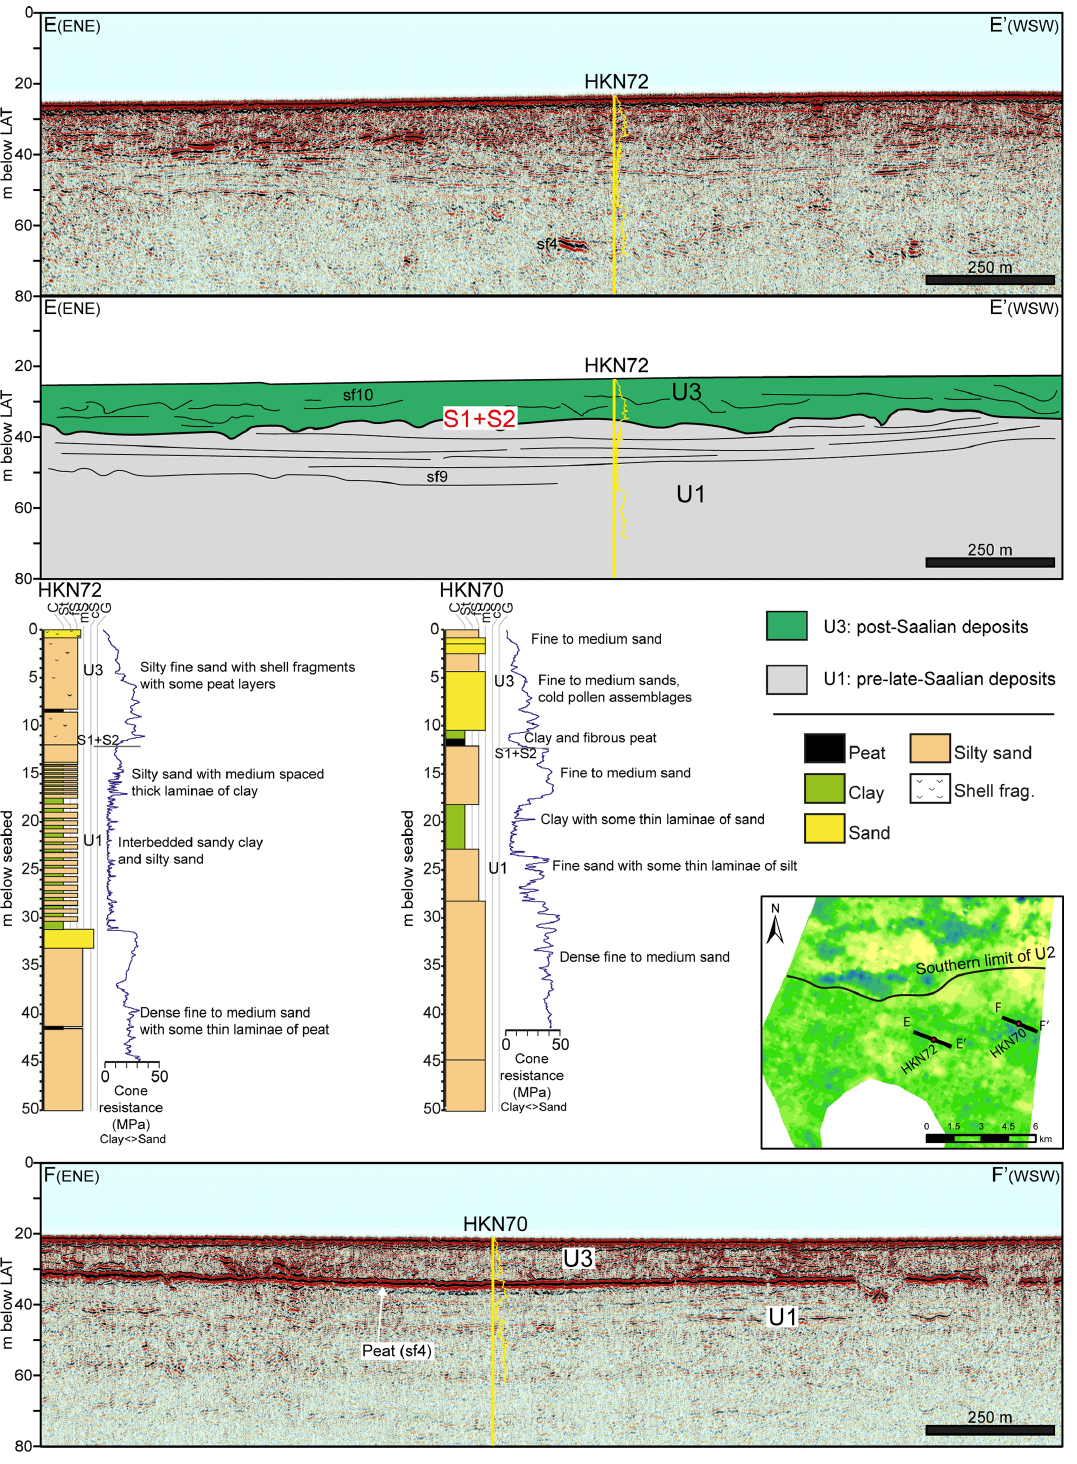
Figure 6. Stratigraphic sections (multi-channel sparker) in the southern sector of the HKN wind-farm area where unit U3 is directly lying on unit U1 (i.e. surfaces S1 and S2 are seismically inseparable). Only the upper 50m of the boreholes is shown. Cone resistance from CPTs obtained at the same sites is displayed on the side of the boreholes and in the seismic profiles. For the location of the seismic profiles and the borehole see the inset map (same map from Fig. 3). The southern limit of unit U2 is also displayed on the map. Grain sizes – C: clay, St: silt, fS: fine sand, mS: medium sand, cS: coarse sand, G: gravel.